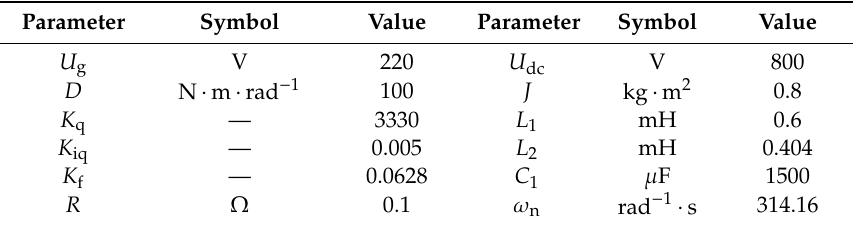
Table 1. Key parameters of the